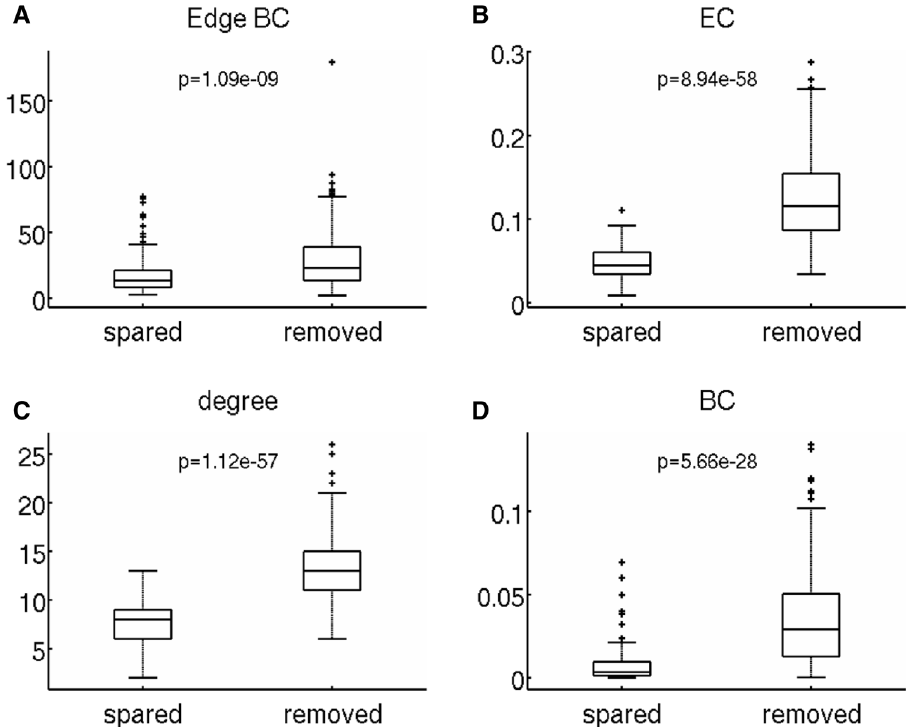
Figure 5. Do the network characteristics of the spared and removed connections differ? A 10% decrease in EC difference spared several connections (compared to a full resection). The network characteristics of the connections that were spared were compared to those that were removed. The network characteristics were edge BC of the connection ( A ), as well as EC ( B ), degree ( C ), and BC ( D ) of the node outside the SOZ that was connected to a SOZ node with the connection in question. Connections to hub nodes were removed significantly more often than they were spared. The p -values were corrected for multiple comparisons using